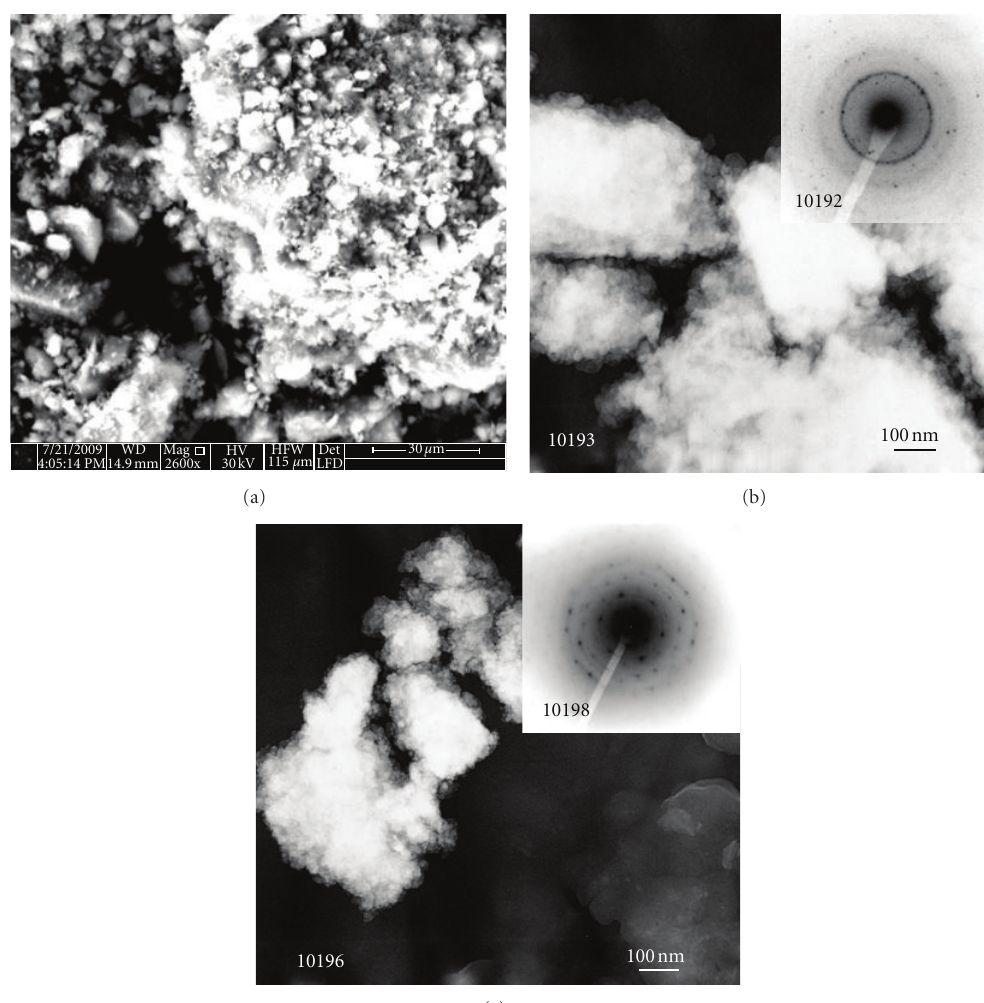
Figure 14: SEM (a) and TEM ((b), (c)) images Si-doped HA after 1 h of HEBM.